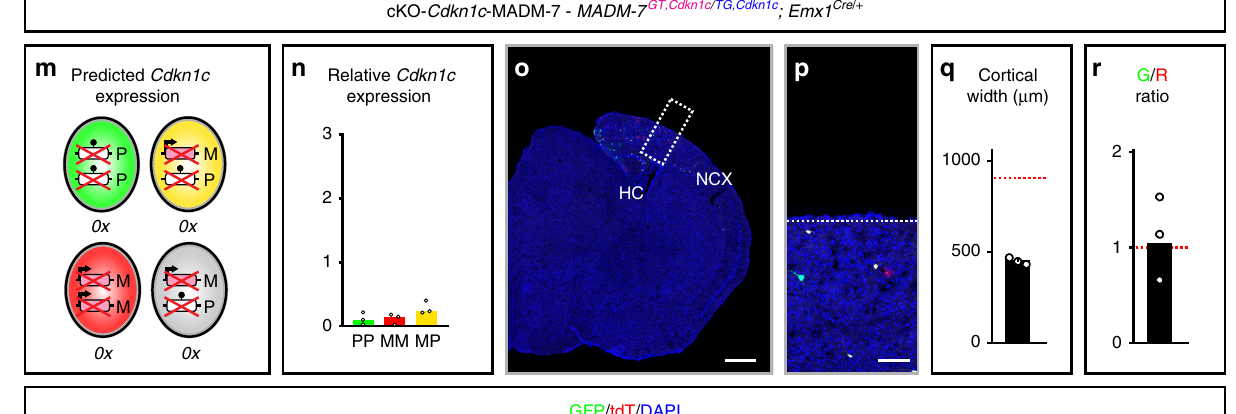
Fig. 3 Cell-autonomous growth-promoting Cdkn1c function is independent of genomic imprinting status. Analysis of Cdkn1c -MADM-7 ( MADM-7 GT/TG, Cdkn1c ;Emx1 Cre/ + ) with maternal deletion ( a – f ), Cdkn1c -MADM-7 ( MADM-7 GT/TG,Cdkn1c ;Emx1 Cre/ + ) with paternal deletion ( g – l ), and cKO- Cdkn1c -MADM-7 ( MADM-7 GT,Cdkn1c/TG,Cdkn1c ;Emx1 Cre/ + ) ( m – r ). The parent from which the MADM cassettes with or without recombined Cdkn1c- fl ox allele ( Cdkn1c ) were inherited is indicated in the respective genotypes in pink (mother) and blue (father). Predicted Cdkn1c expression in GFP + (green), tdT + (red), GFP + /tdT + (yellow) and unlabeled (gray) MADM-labeled cells ( a , g , m ); and true relative levels of Cdkn1c expression in GFP + (green bar), tdT + , (red bar), GFP + /tdT + (yellow bar) MADM-labeled cells ( b , h , n ) in Cdkn1c -MADM-7 with maternal deletion ( a , b ), Cdkn1c -MADM-7 with paternal deletion ( g , h ), and cKO- Cdkn1c -MADM-7 ( m , n ) at E16 are indicated (MM, matUPD; PP, patUPD; MP, control). Data points indicate individual animals ( n = 5 – 7).Outlier values are not shown (see Source Data File). Bars indicate median. Imprinting of Cdkn1c (arrow, expression; ball on stick, repression) and predicted expression (0×, 1×, 2×) is indicated. Parental origin of chromosome is indicated (M, maternal; P, paternal) and conditional deletion of Cdkn1c is marked with red cross. MADM- labeling (GFP + , green; tdT + , red; GFP + /tdT + , yellow) ( c , d , i , j , o , p ), cortical width ( μ m) is shown with an error bar representing SEM ( e , k , q ), and G/R ratio (geometric mean) of single MADM-labeled cortical projection neurons ( f , l , r ) in Cdkn1c -MADM-7 with maternal deletion ( c – f ), Cdkn1c -MADM-7 with paternal deletion ( i – l ), and cKO- Cdkn1c -MADM-7 ( o – r ) at P21 are indicated. Boxed areas in overview images ( c , i , o ) show representative images of the extent of microcephaly at higher resolution ( d , j , p ). Nuclei were stained using DAPI (blue). Scale bar, 500 μ m (overview ( c , i , o )) and 90 μ m (inset ( d , j , p )). Note the decreased numbers of Cdkn1c − / − cells when compared to Cdkn1c + / + cells in ( f ) and ( l ) but equipotency/equal numbers of Cdkn1c − / − cells in ( r ) regardless of the UPD status. Data points ( e , f , k , l , q , r ) indicating individual animals ( n = 3). NCX neocortex, HC hippocampus. Source data are provided as a Source Data fi